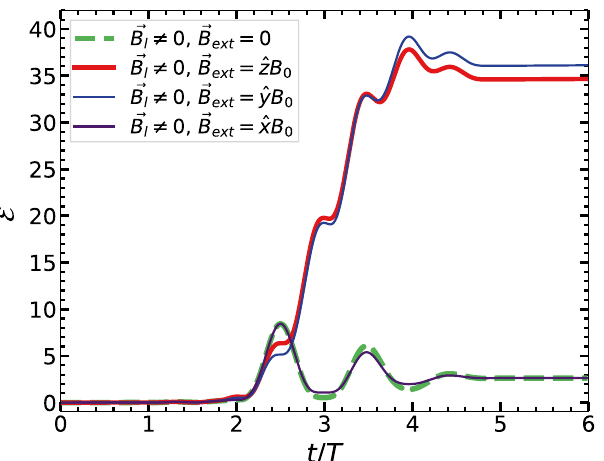
Figure 4. RSM results: Time vs absorbed energy in units of U p of the single electron (in Fig. 2) for different B ext : ˆ z B ˆ x B ˆ y B 0 , (ii) B (i) B ext ext = ext , (iii) B ext = ext . Laser fields ( E l , B l ) and magnitude of ext and (iv) B ext = = 13.37 kT are as in Fig. 2a2,b2,c2. Cases (ii) and (iii) are only two energetically favorable orientations of B ext | | ≈ B ext .